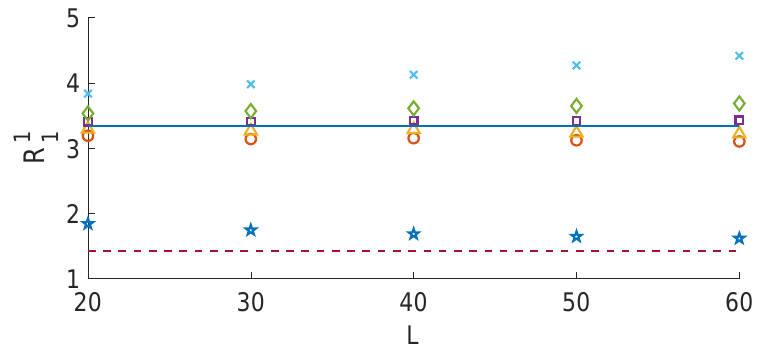
= 1, with E = E = E 0 , b d P 0